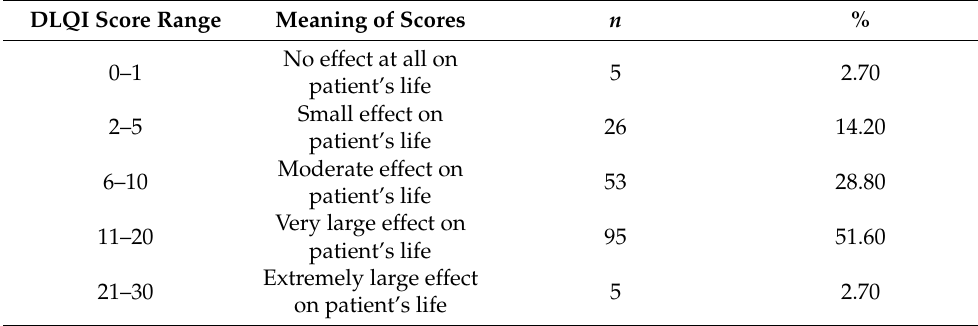
Table 3. Distribution of patients with AD based on the DLQI score ranges and their significance on the patients’